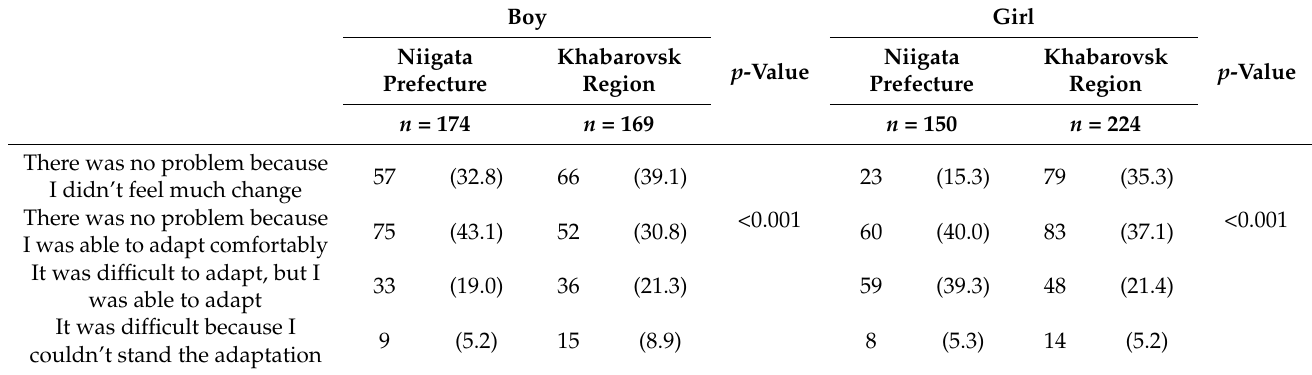
Table 4. “Have you adapted to a new lifestyle to prevent the spread of infection?”.